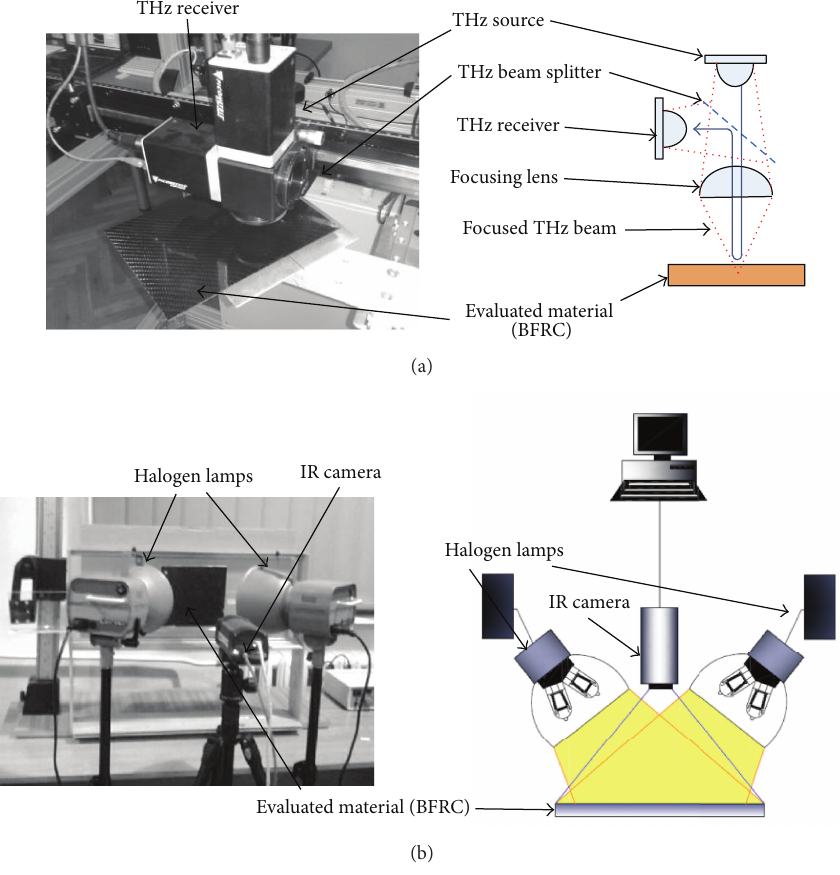
Figure 2: The measurement setups: (a) terahertz inspection system and (b) IRT